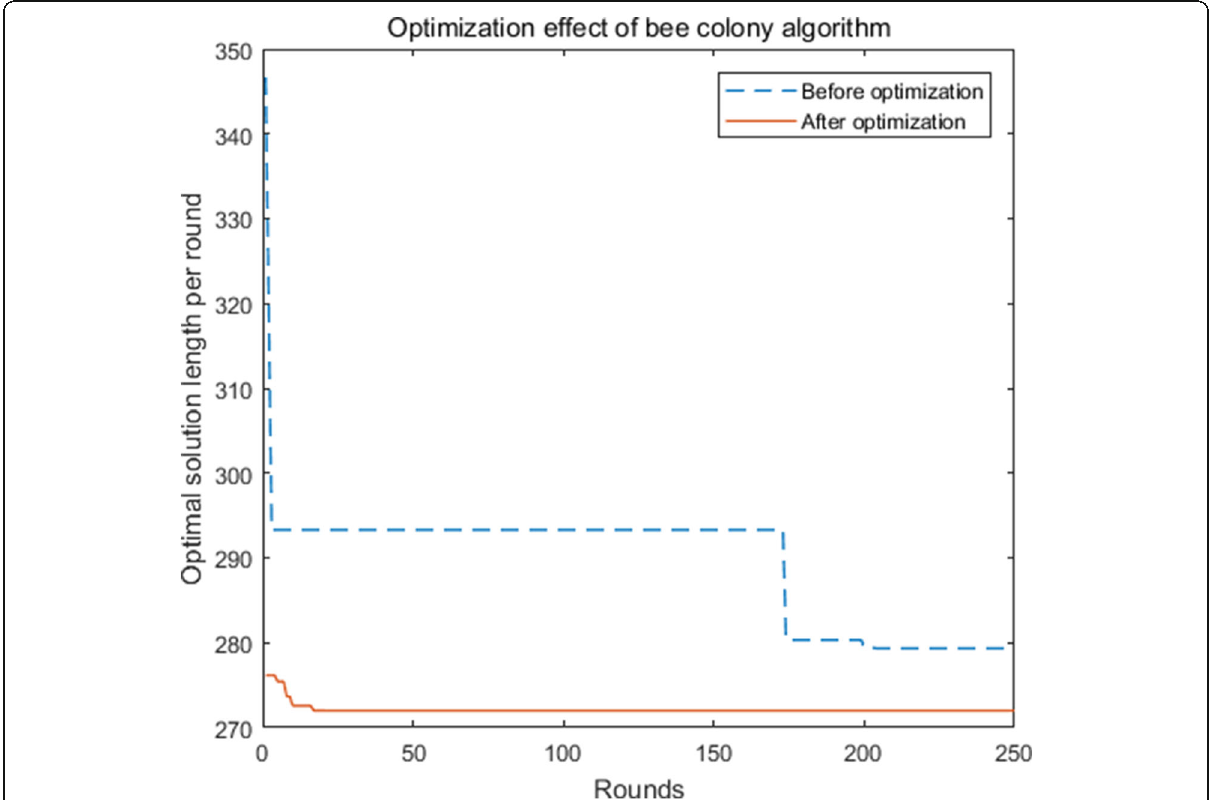
Fig. 13 Performance diagram of bee colony algorithms. It shows the optimization effect of window screening mechanism on ABC